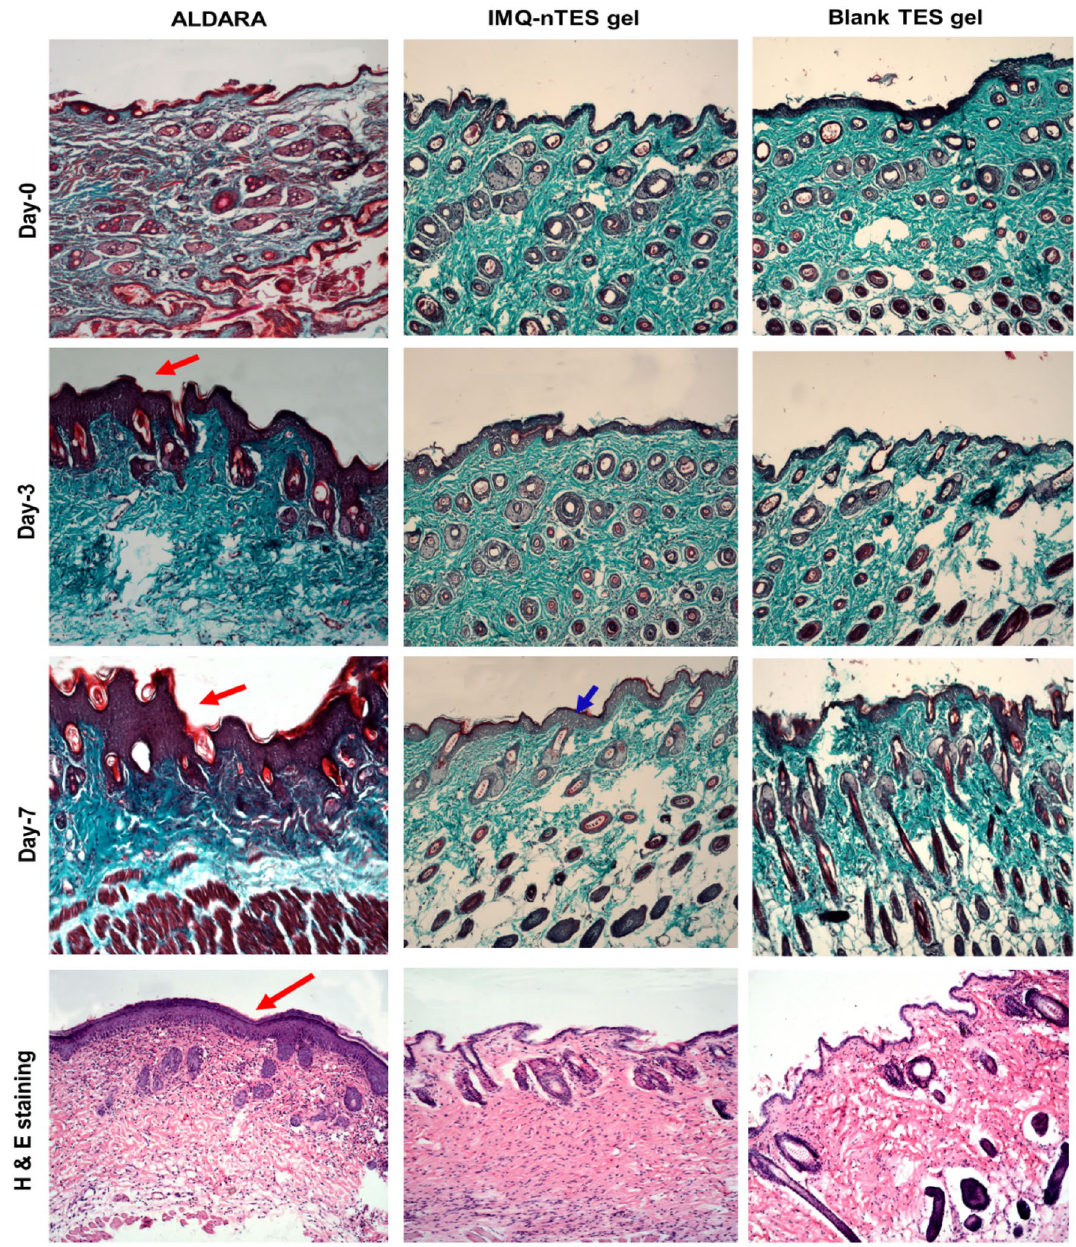
Figure 7. Trichome stained and H & E stained micrographs showing epidermal architecture of excised skin from dissected BALB/c mice from ALDARA, Blank TES gel and IMQ-nTES gel